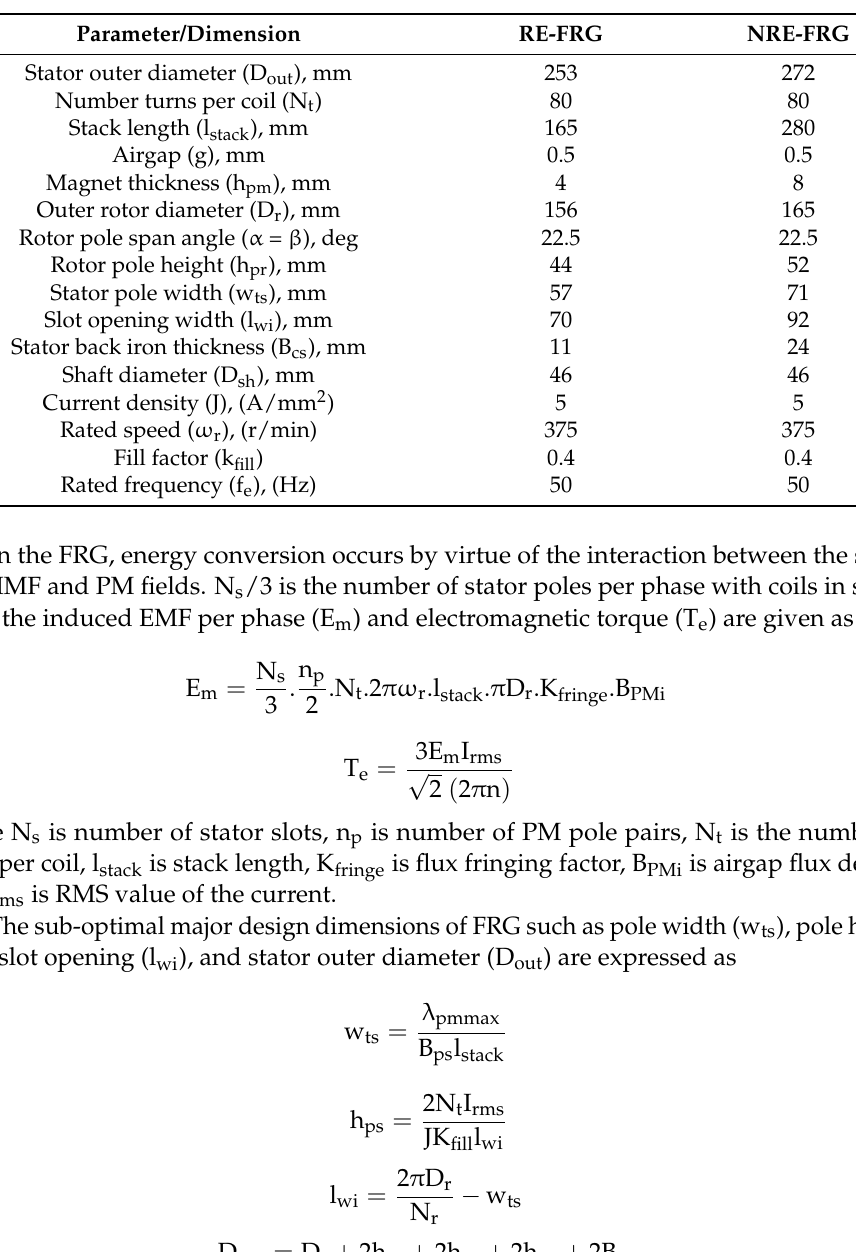
Table 1. Design specifications/dimensions of RE-FRG and